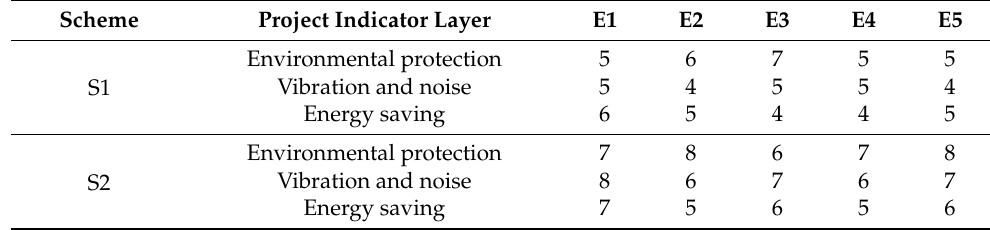
Table A3. Evaluation results of green